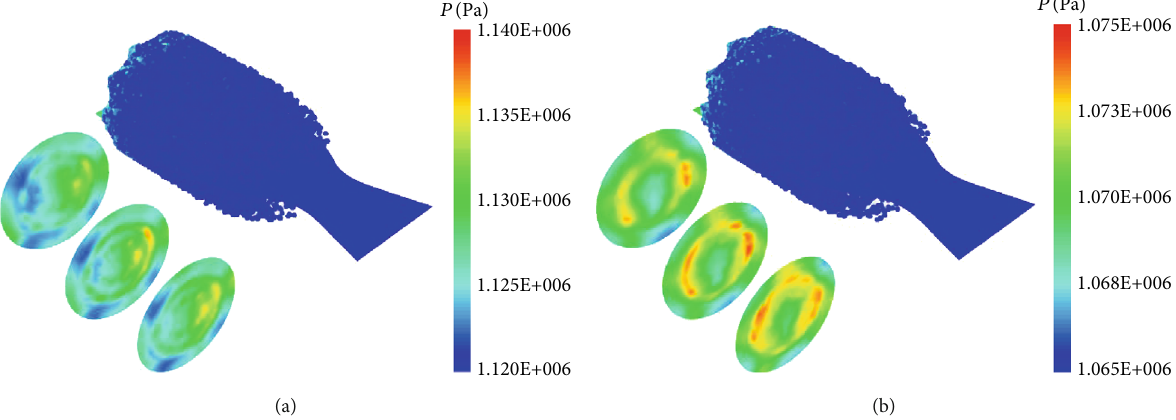
Figure 17: The acoustic pressure contours in Case 5. (a) 8.19025ms, MMH. (b) 8.84402ms,